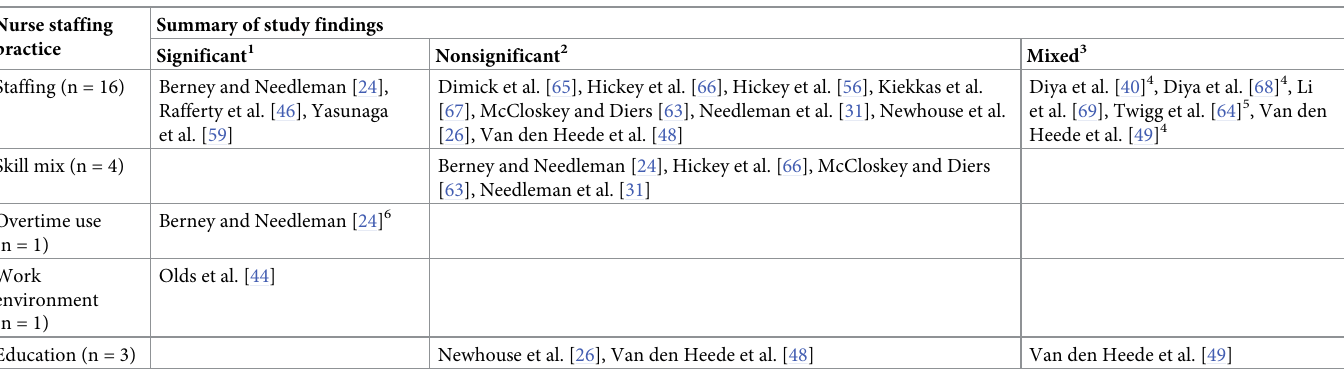
Table 3. Nurse staffing practices in association with in-hospital mortality.